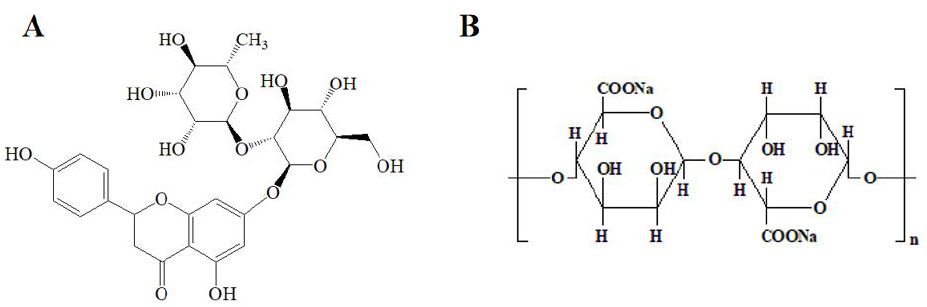
Figure 1. Chemical structures of ( A ) naringin and ( B ) SA.